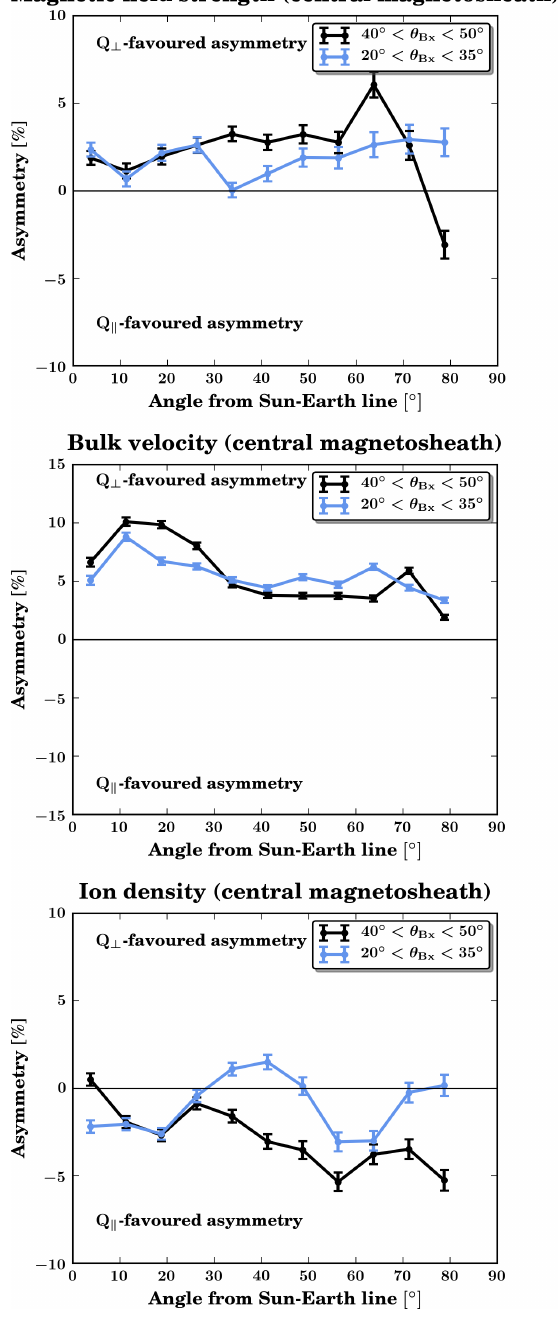
Figure 7. Asymmetries in the central magnetosheath as obtained from statistics of THEMIS spacecraft observations. From top to bottom: magnetic field strength, bulk velocity, and ion density. The black curves correspond to data with a cone angle near the Parker < 50 ◦ ) and the blue curves to data spiral orientation (40 ◦ < θ B x < 35 ◦ with low cone angle values (20 ◦ < θ B x